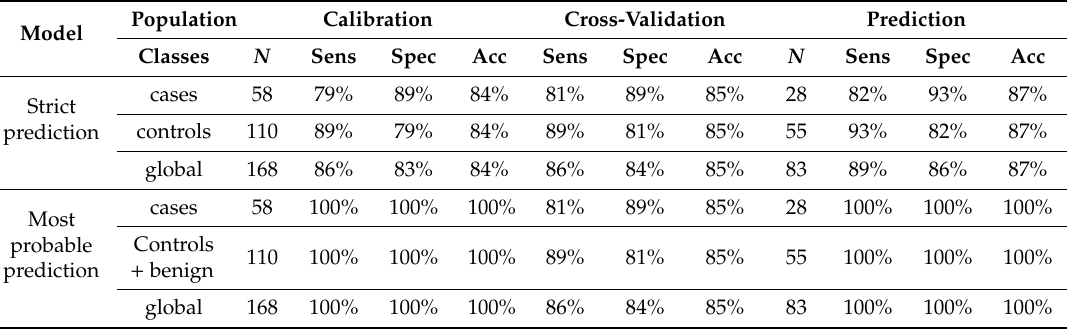
Table 2. Figures of merit for the KNN model developed for cases vs. controls + benign: sensitivity (Sens), specificity (Spec), and accuracy (Acc) are reported for the strict and the most probable assignation of the